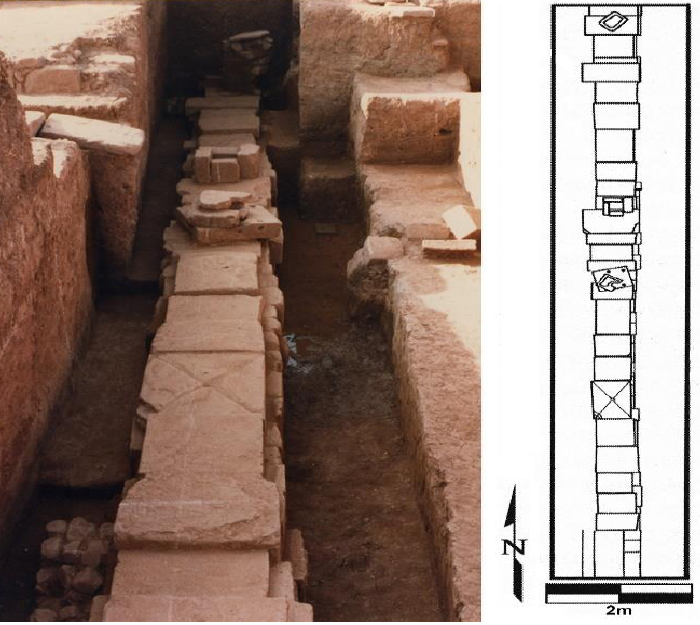
Figure 48. Excavated subterranean channel P located ~3 m below the ground surface. Photo by au- thor.